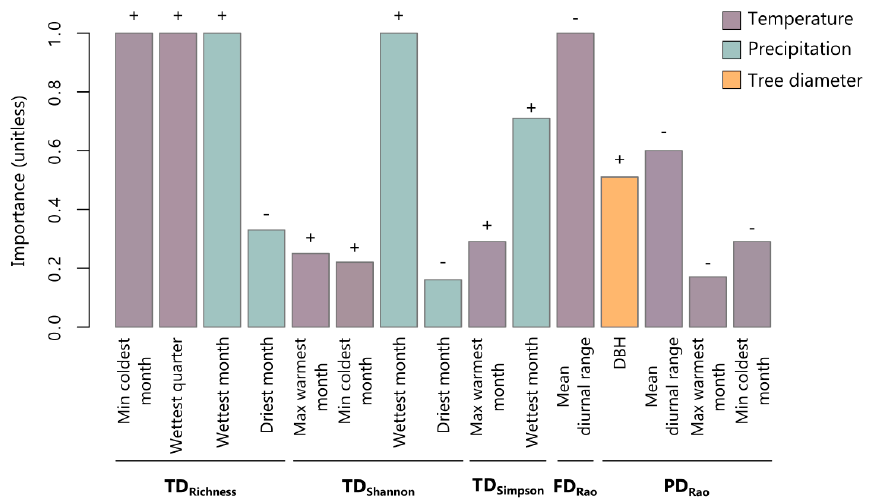
* Asterisk indicates significant spatial autocorrelation according to Moran index.